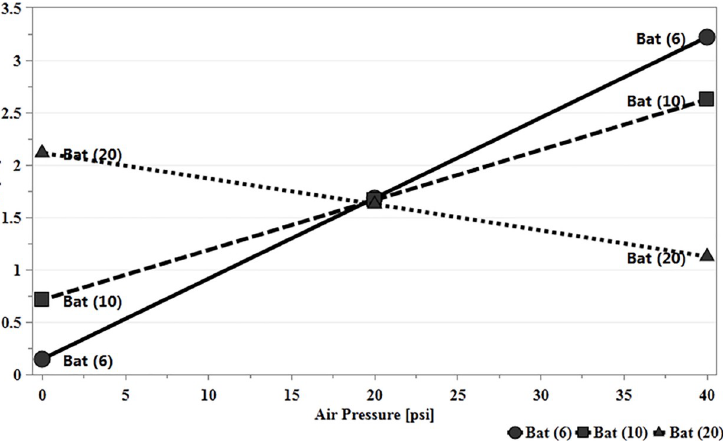
Fig 12. Interaction effect plot of batch size with increasing air flow on content uniformity while other factors were maintained at their middles values.